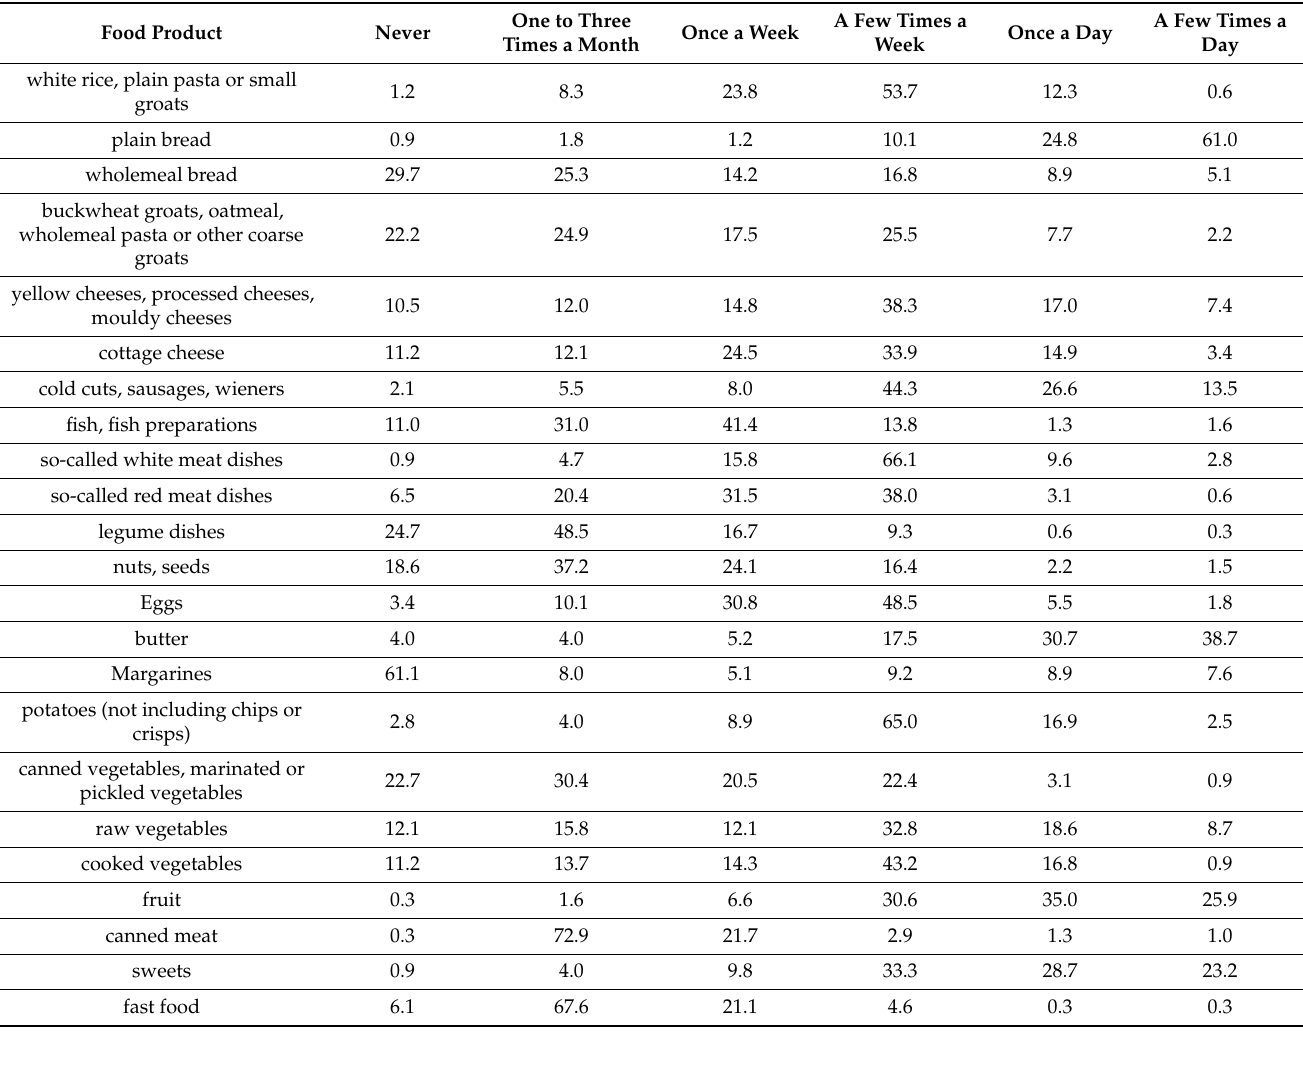
Table 3. Frequency of consumption (% of answer) of selected food products for all the schoolchildren.